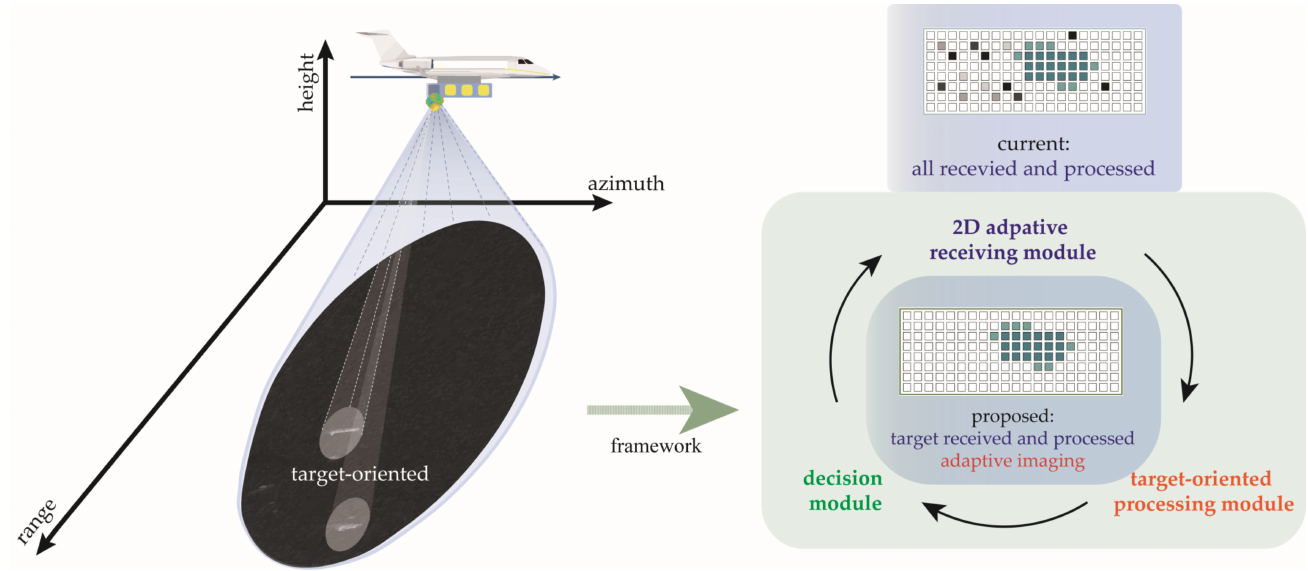
Figure 5. The proposed target-oriented imaging concept and its realization